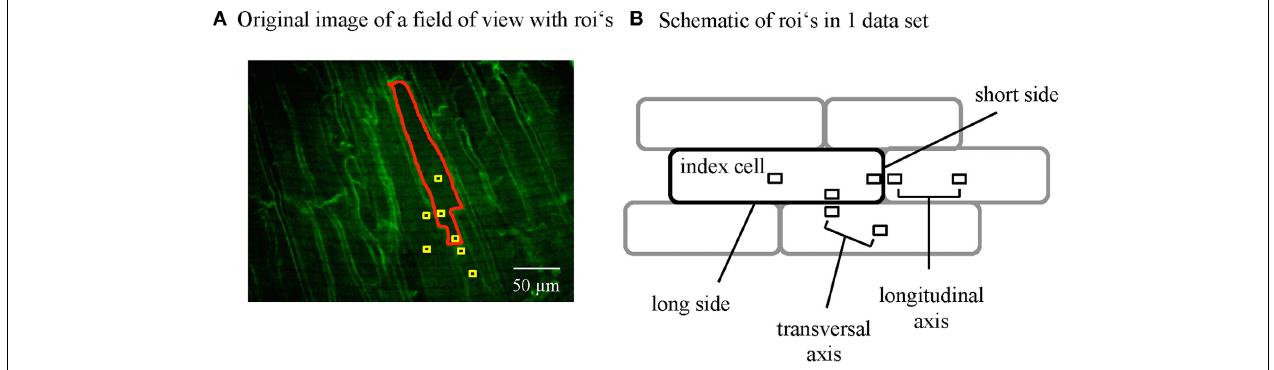
FIGURE 3 | Data analysis of subcellular Ca signals from adjacent myocytes. (A) Regions of interest (ROIs) were positioned within the single cells where the Di-4-ANEPPS labeled the plasma membranes to visualize the